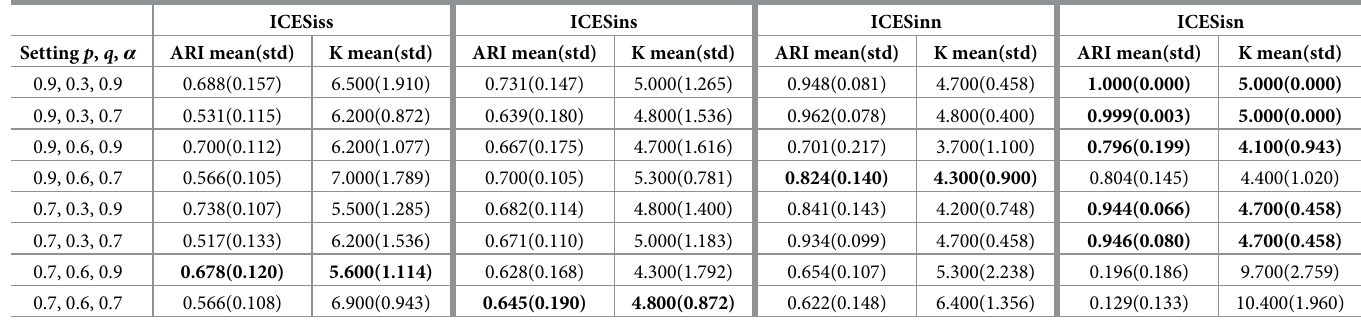
Table 14. The performance of ICESi methods at small-size networks with quantitative features at the nodes with 50% noise features replicated; with selected data pre-processing for each algorithm: The average ARI index and its standard deviation over 10 different data sets. ICESiss ICESins ICESinn ICESisn Setting p , q ,